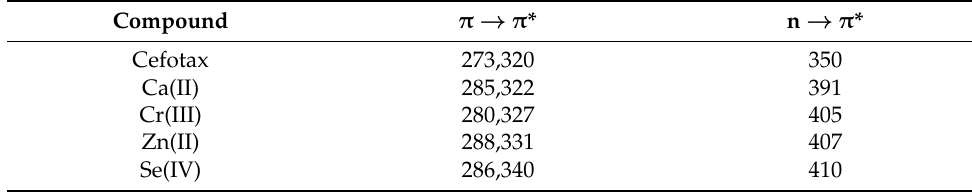
Table 3. UV–vis spectra of cefotaxime and its metal complexes.